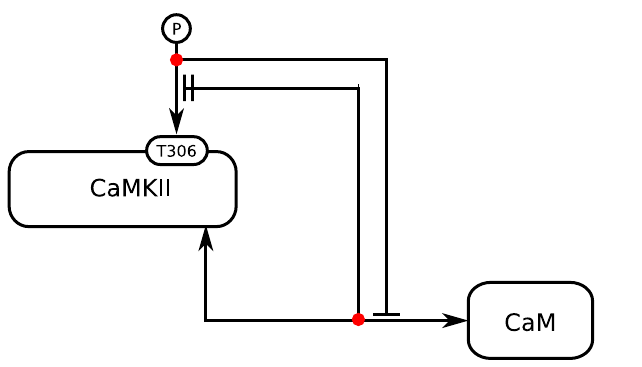
Figure 2.3: The Entity Relationship glyph for outcome .